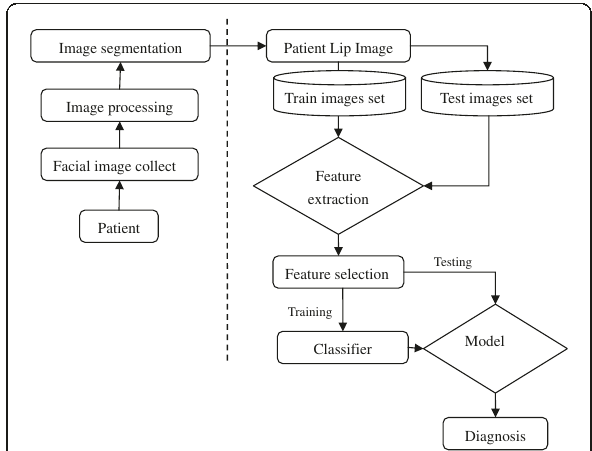
Figure 1 A framework of the proposed lip image classification